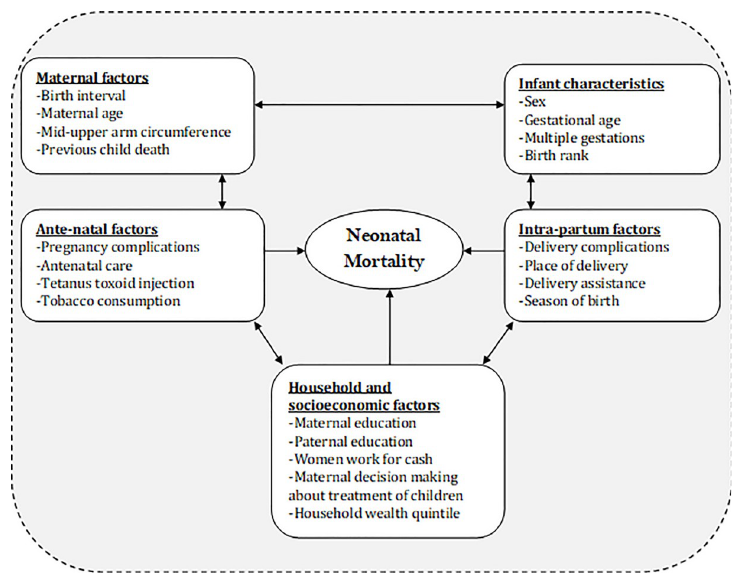
Fig 1. Conceptual framework for determinants of neonatal mortality [adopted from Paudel et al [28] ] .